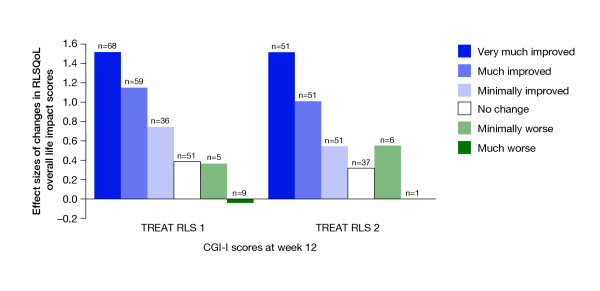
Responsiveness. Effect sizes as a measure of the change in RLSQoL overall life impact change scores between baseline and week 12, by CGI-I scores at week 12. p < 0.0001 for comparisons of the change in RLSQoL overall life impact scores among CGI-I groups in both TREAT RLS 1 and 2 (Kruskall-Wallis test). The sample size of n = 1 in the 'worsened' group in TREAT RLS 2 meant that effect sizes could not be calculated. RLSQoL = RLS Quality of Life questionnaire. CGI-I = Clinical Global Impression 'Improvement'.